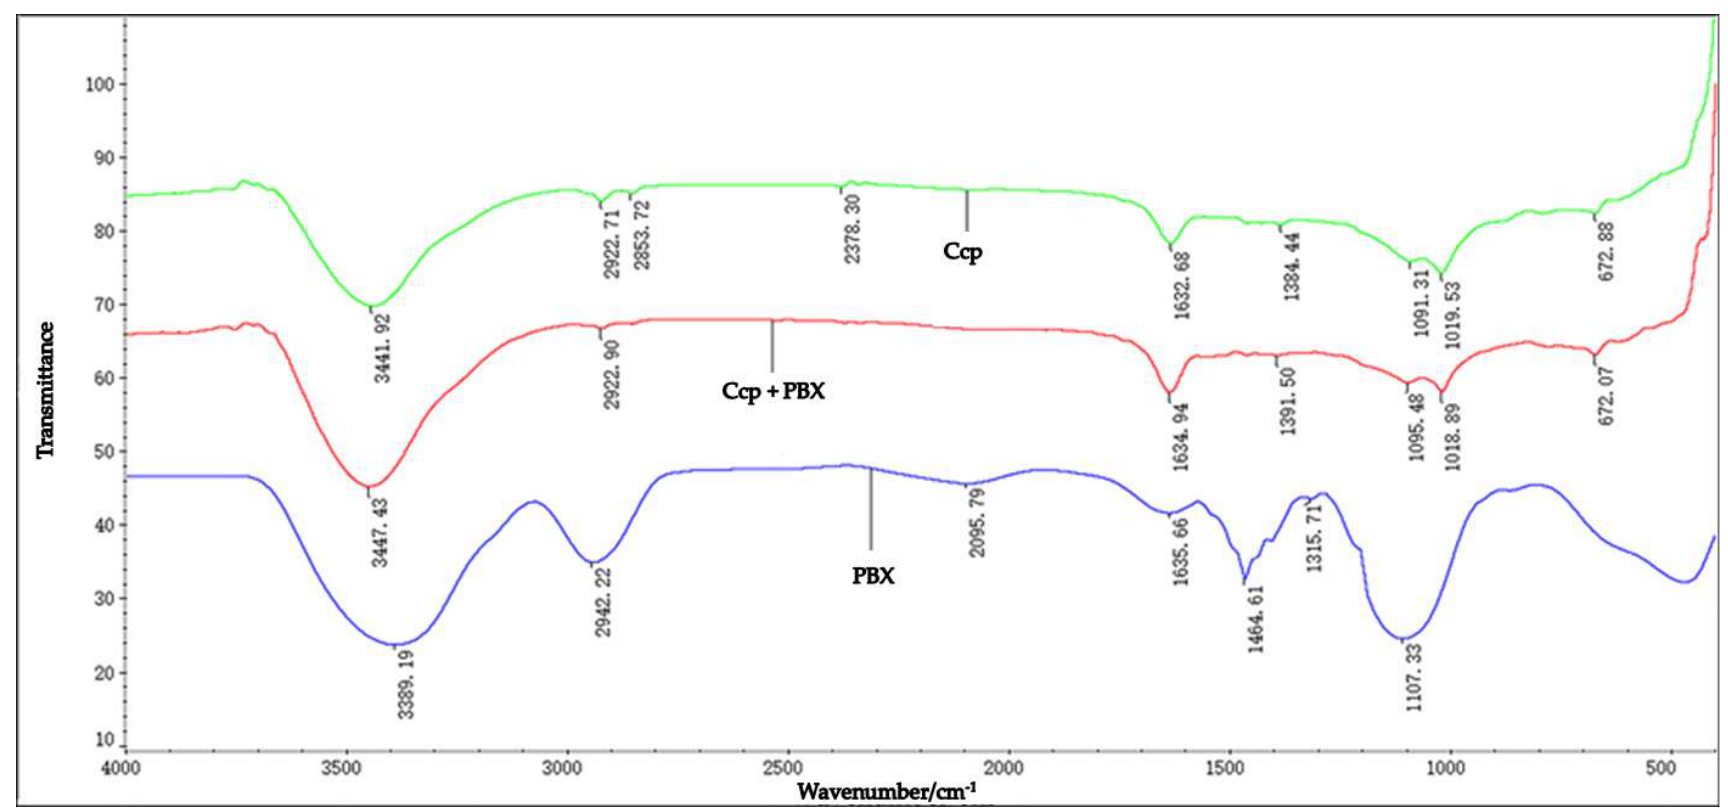
Figure 7. Infrared spectra of chalcopyrite before and after treatment with PBX.